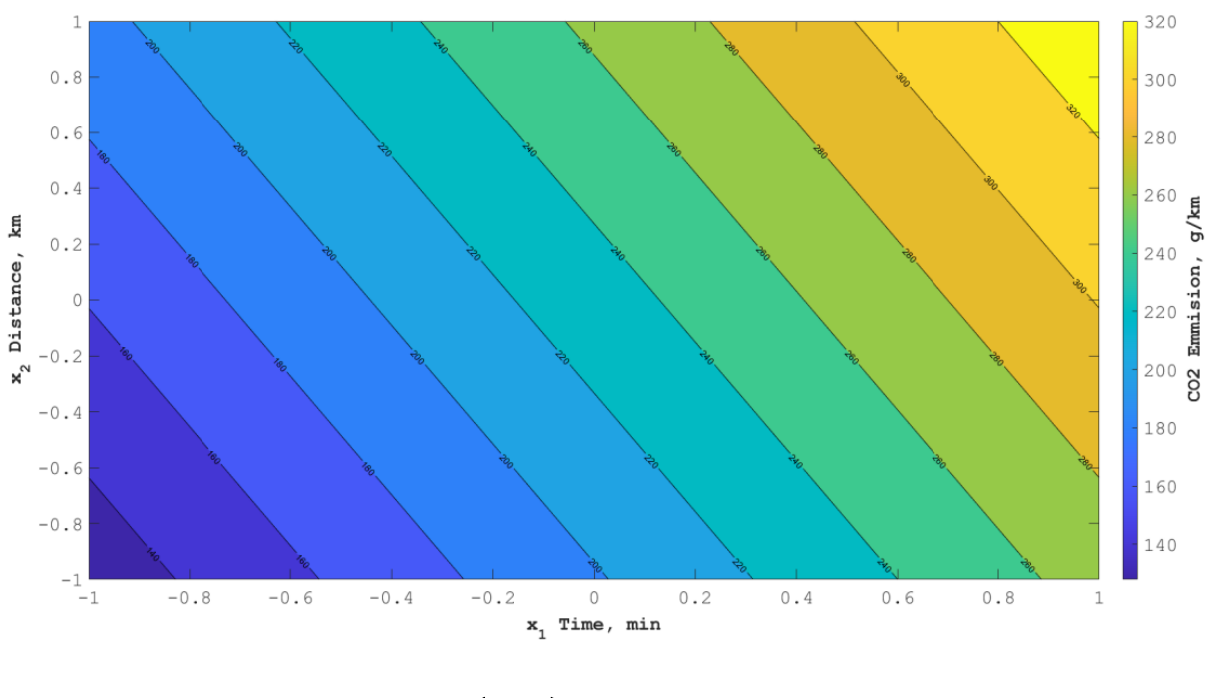
Figure 8. Change in CO 2 emission depending on the variability of factors x 1 and x 2 for a vehicle (ICE) moving at a temperature of 15 °C (x 3 = −1 ).